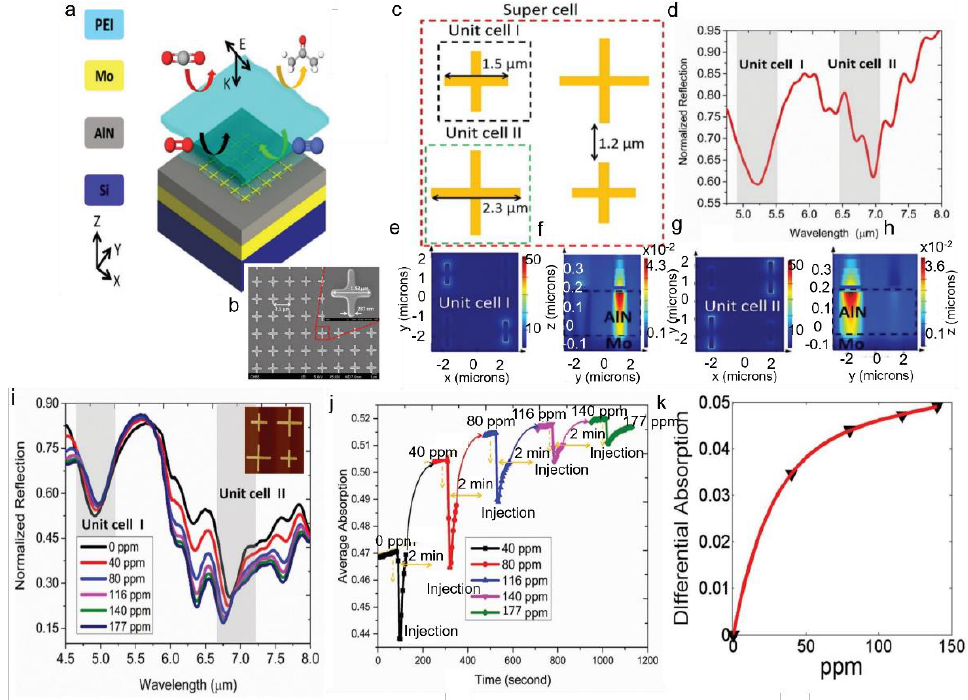
Figure 8. ( a ) Proposed ‘hybrid metamaterial’ absorber integrated with thin-film membrane for selective gas sensing. ( b ) FESEM (field emission scanning electron microscopy) image of the metamaterial array (inset shows the unit cell). ( c ) Design of the supercell composed of unit cell I and unit cell II for multiplexed sensing. ( d ) Simulated reflection spectrum of the supercell geometry overlaid by the gas-selective layer. Polarisation of the incoming radiation is fixed along y-axis ( e ), ( f ) electric field (at xy plane) and magnetic field (at xz plane) distribution, respectively, when unit cell I is resonant at 5.25 µ m. ( g , h ) Electric field (at xy plane) and magnetic field (at xz plane) distribution, respectively, when unit cell II is resonant at 6.75 µ m. ( i ) Steady-state sensing characteristics of the multiplexed platform. Inset: fabricated superpixel. ( j ) Dynamic absorption behaviour within the spectral window: 5–8 µ m. ( k ) Differential absorption at steady state fitted under two parameter exponential models (f(x) = a ∗ exp(b ∗ x) + c ∗ exp(d ∗ x)) indicating saturation behaviour of the sensor as the gas concentration increased in continuous mode. The fitting values of a, b, c and d are 0.04555,